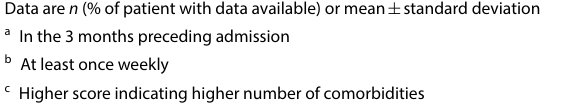
Number of patients with data available Patients